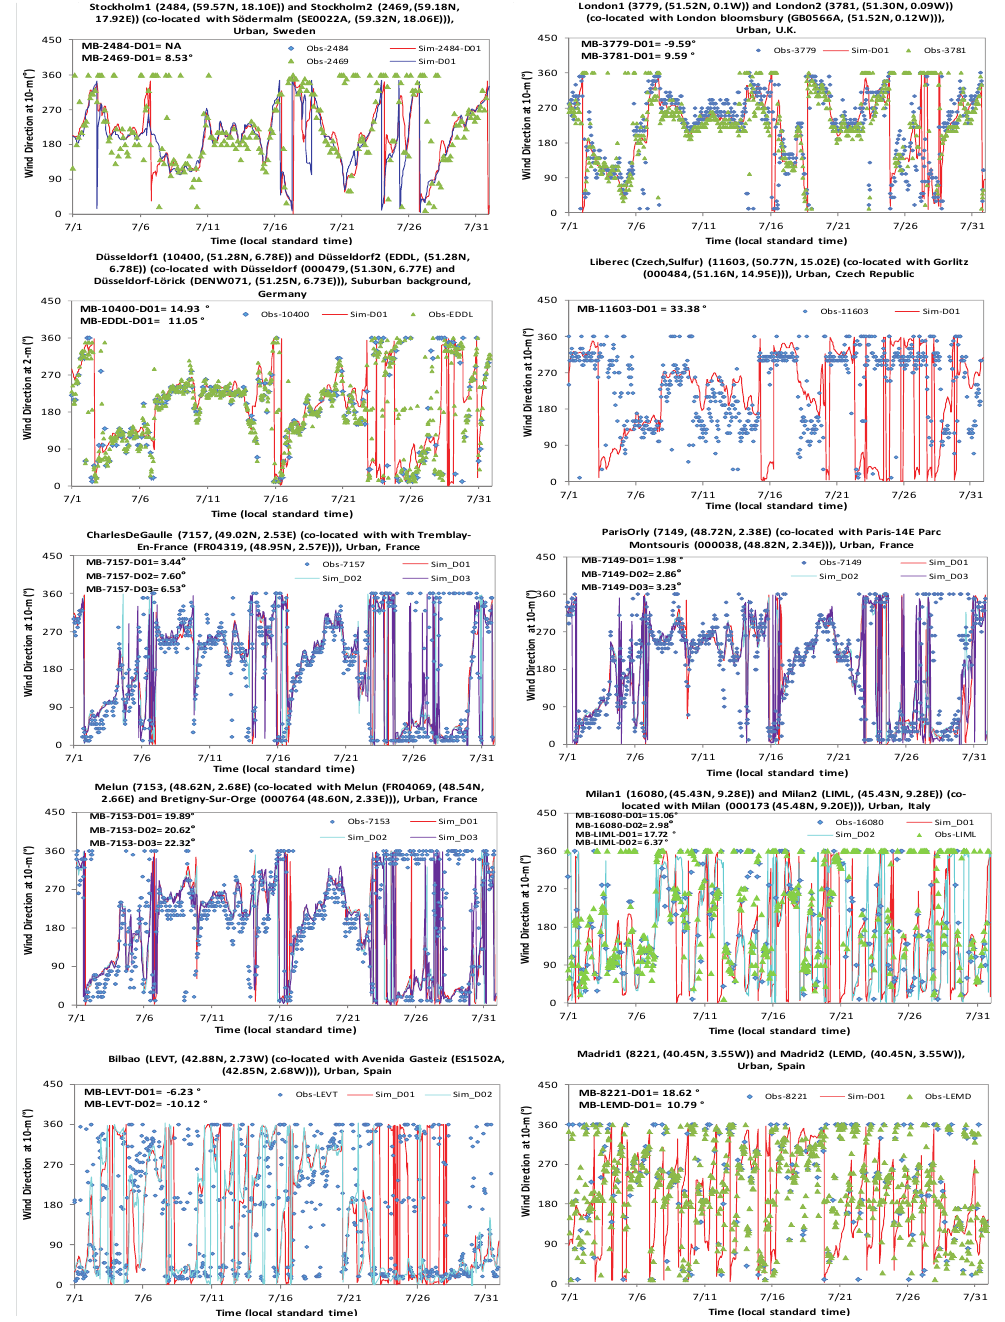
Figure 15. Simulated and observed 10-m wind direction in July 2001 at selected sites. Statistics is not available (NA) at one site (Stockholm 1) where observations were not available.